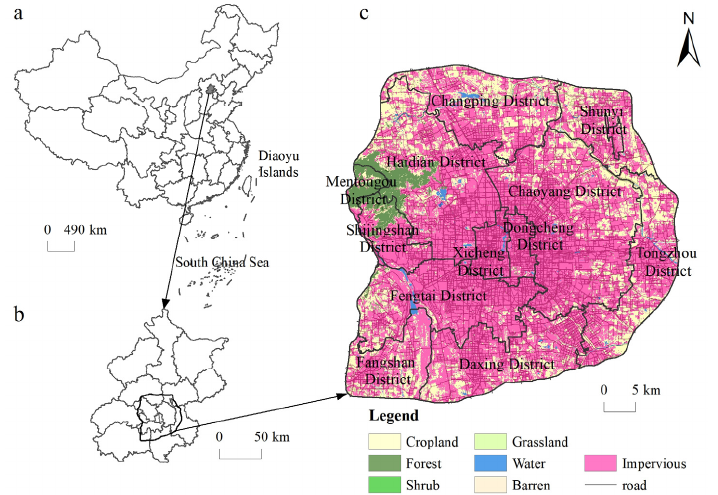
Figure 1. The geographical location of the study area: ( a ) China, ( b ) Beijing, ( c ) The sixth ring road of Beijing.